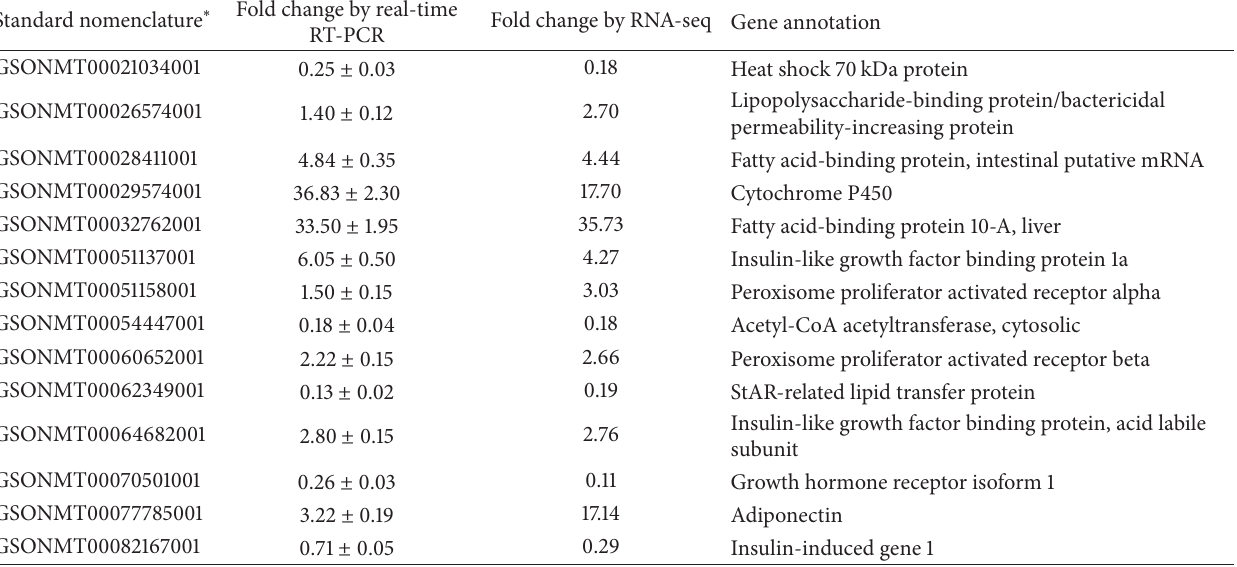
Table 3: Comparison of fold differences in 14 differentially expressed genes detected by transcriptome sequencing and real-time RT-PCR